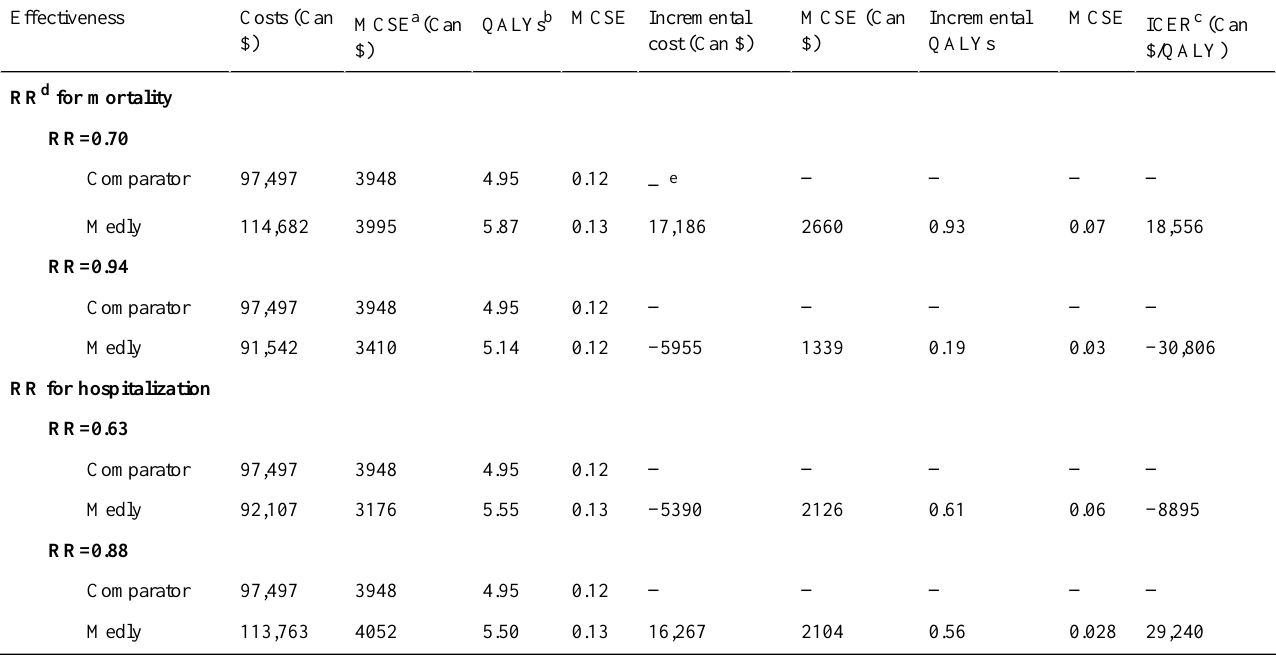
Table 8. Deterministic results for the upper and lower limits of effectiveness in reducing mortality and hospitalization